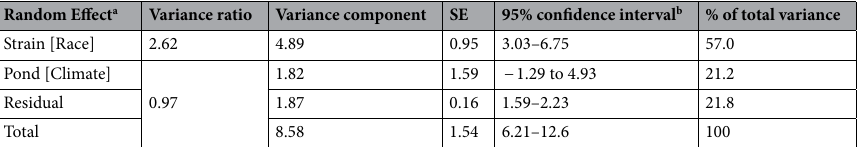
Table 1. Summary of the fit of a mixed model for doubling-time data of Botryococcus braunii wild strains. Model R 2 = 0.79; n = 380; AIC = 1570; BIC = 1609. REML Variance Component Estimates. a Strain was nested in Race, and Pond was nested in Climate. b The lower–upper 95% confidence limits for the variance component. Intervals including zero indicate non-significant variance components ( P > 0.05).